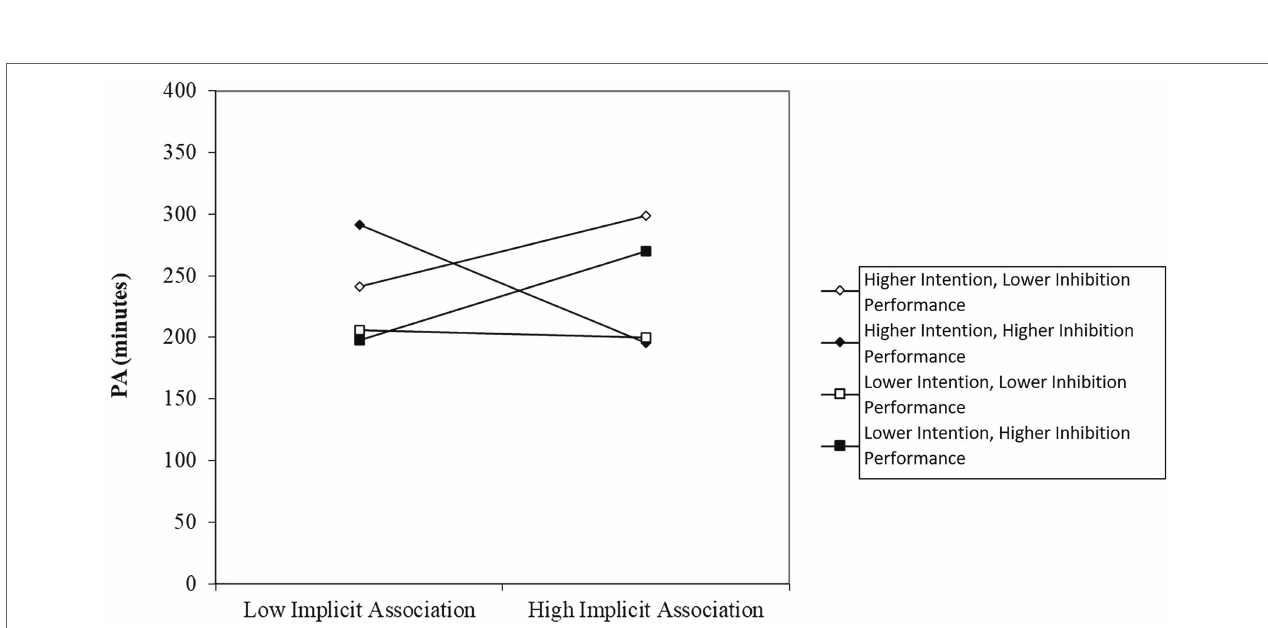
FIGURE 2 | Moderating effect of shifting for the intention–behavior relationship. Note that higher shifting performance is referred to low shifting costs while lower shifting performance is referred to high shifting costs. PA (minutes) = physical activity in minutes at t2.